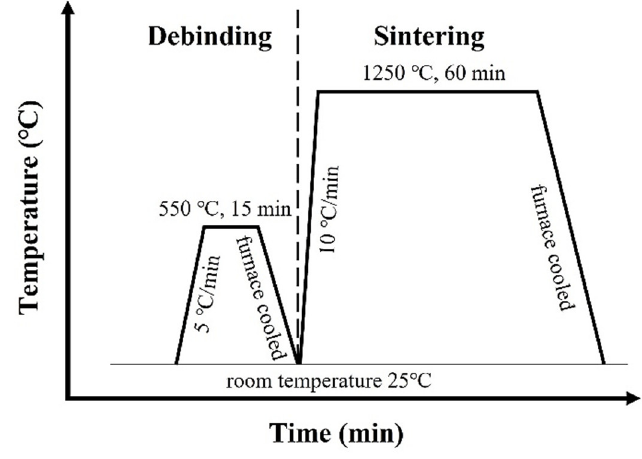
Figure 2. The schematic of the debinding and sintering schedule.